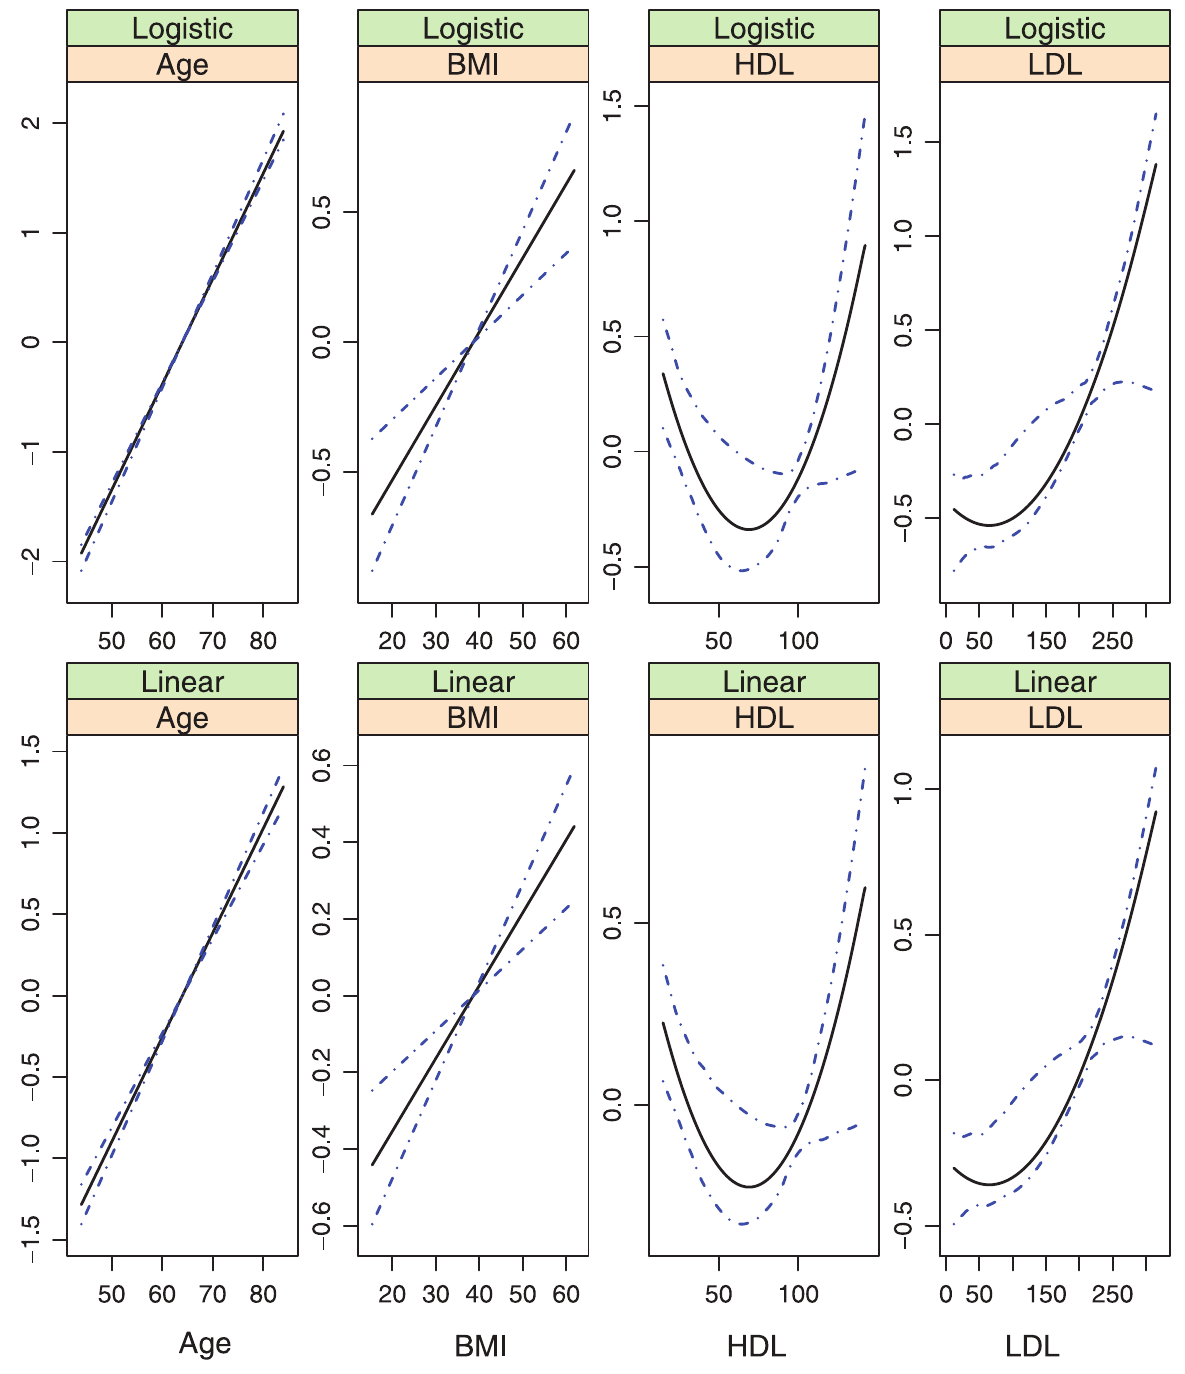
Figure 3. Model (i.2): estimated covariate effects for age, BMI, HDL, and LDL. The solid line is the estimate. The dash-dotted lines are the point-wise 95% confidence intervals. The y-axis is the value of the function.